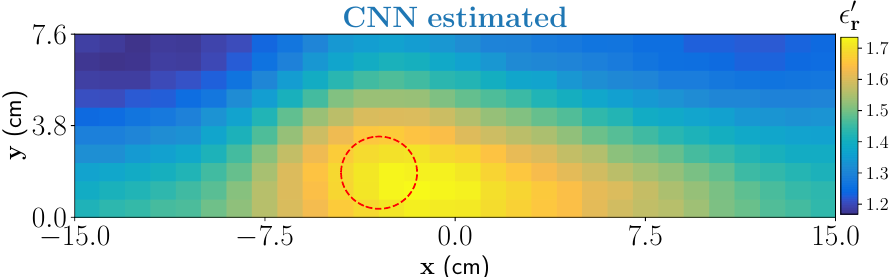
Figure 10. CNN estimation of one dominant wet-spot with 43% moisture inside the